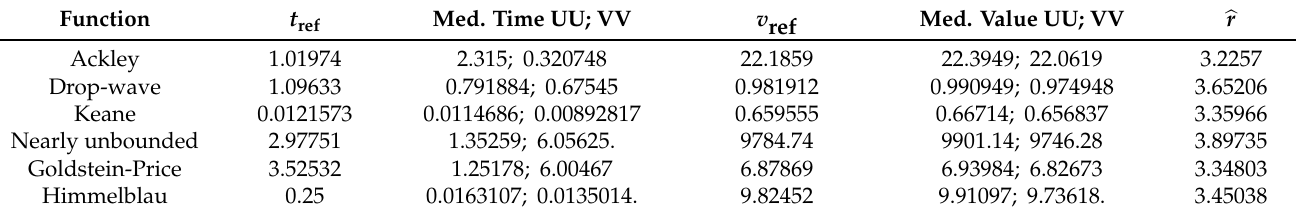
Table 1. Results comparing the parallelised and the nonparallelised